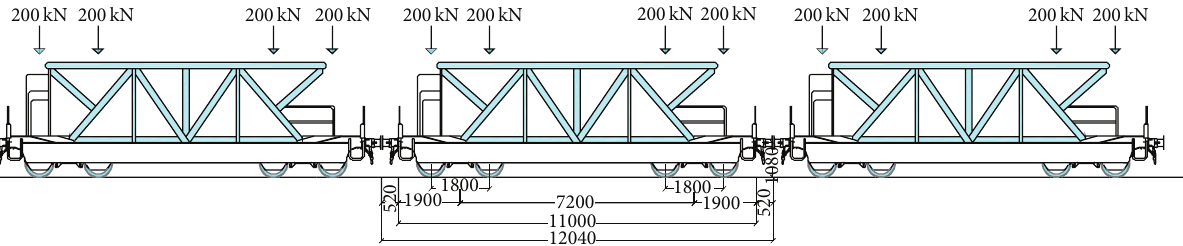
Figure 3: Multiple coaches for ballast train.